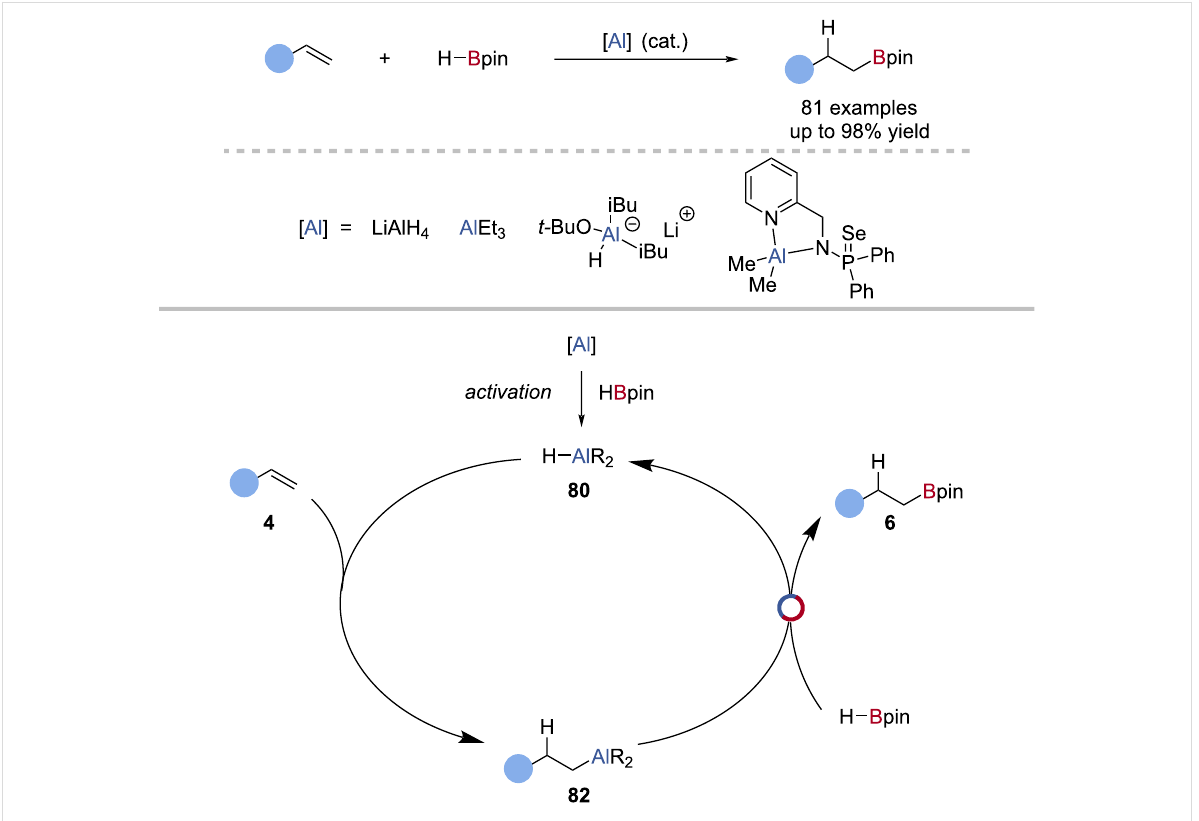
Scheme 20: Aluminium-catalysed hydroboration of alkenes and the proposed